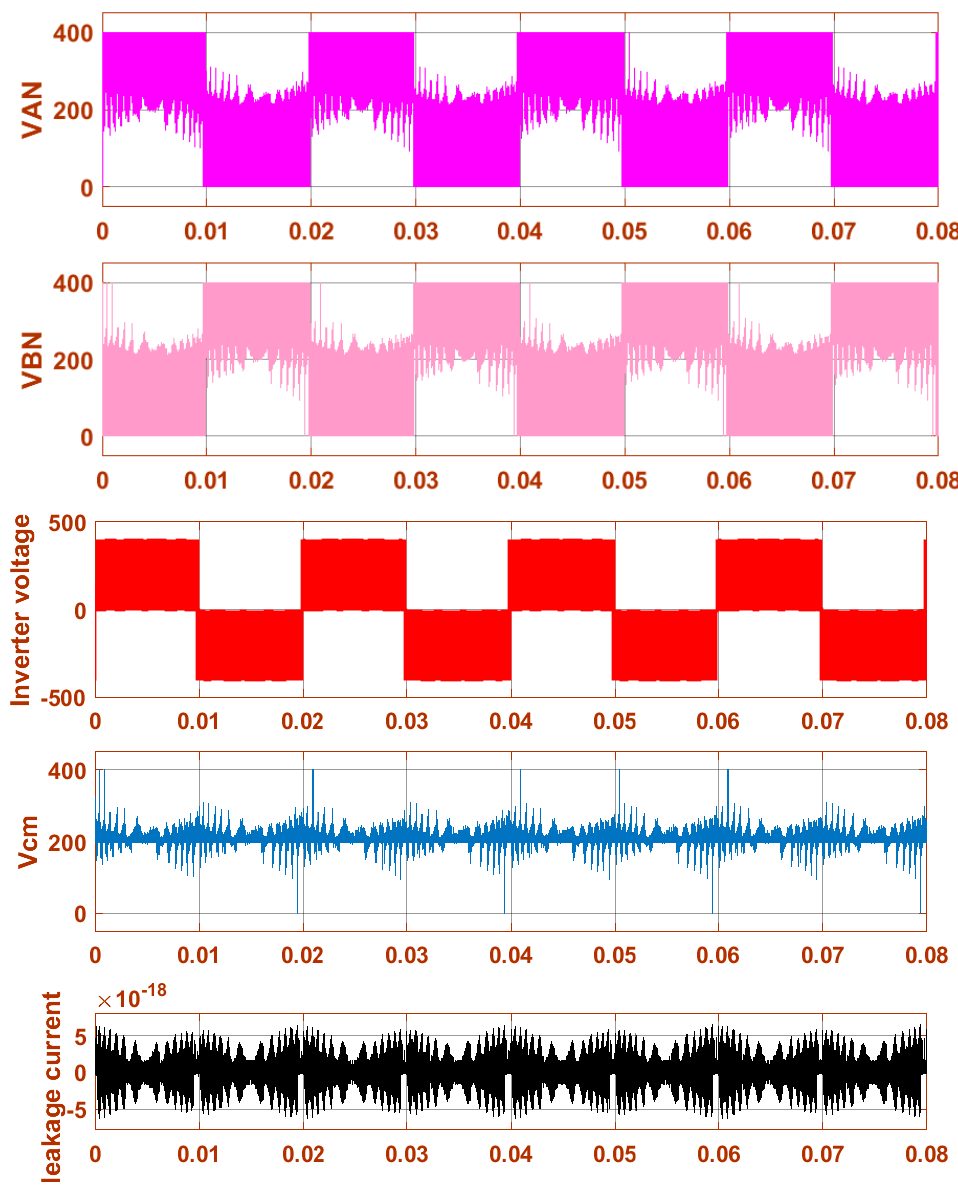
Figure 13. Waveform of V AN , V BN , inverter voltage and V cm , leakage current of H5 inverter.